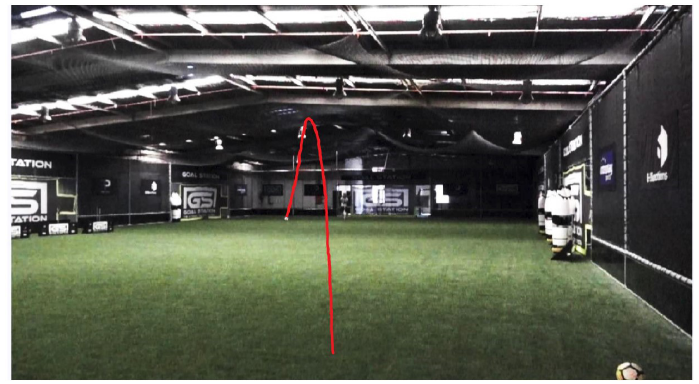
Figure 12. Example of typical trajectory of soccer ball.